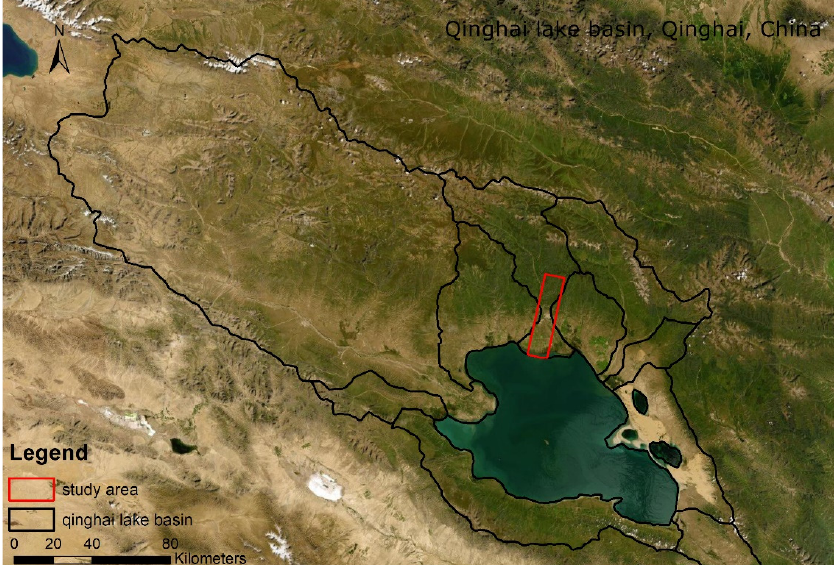
Figure 3. The study area at Qinghai Lake basin, Qinghai Province, China.